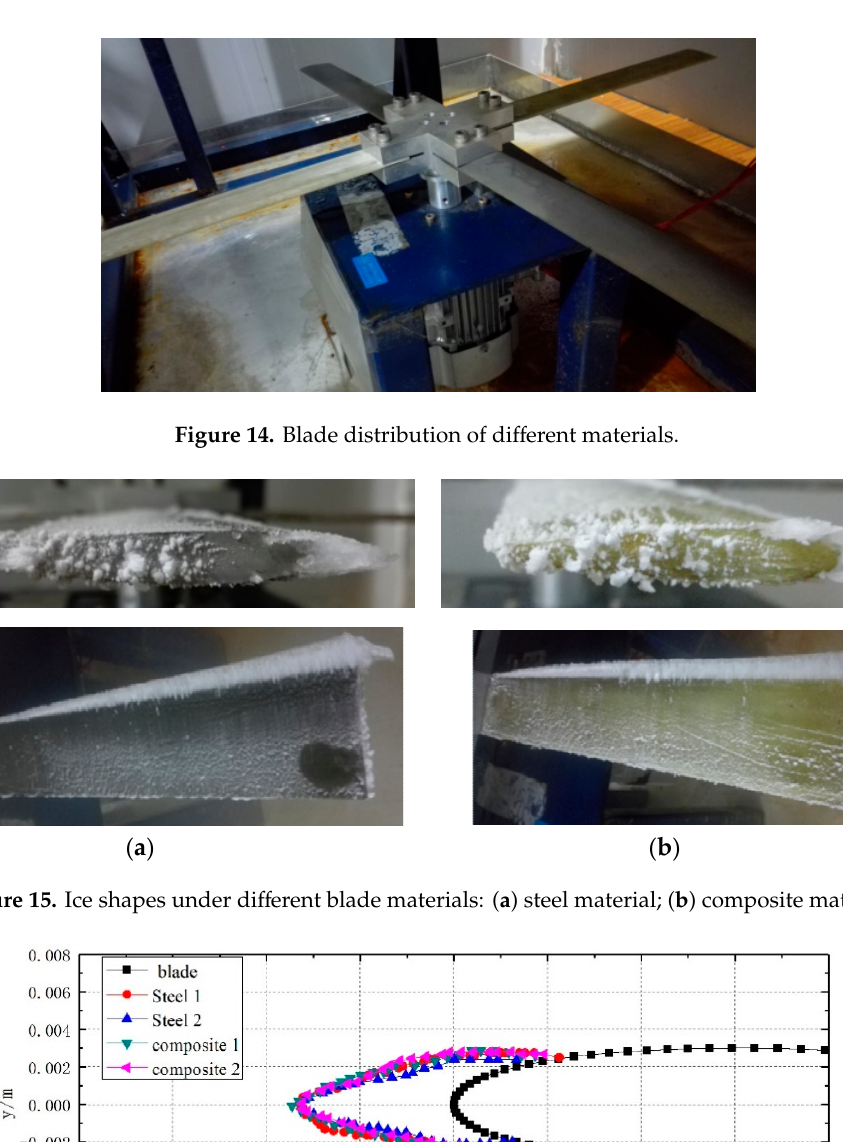
Figure 16. Comparison of ice shapes under different blade materials.